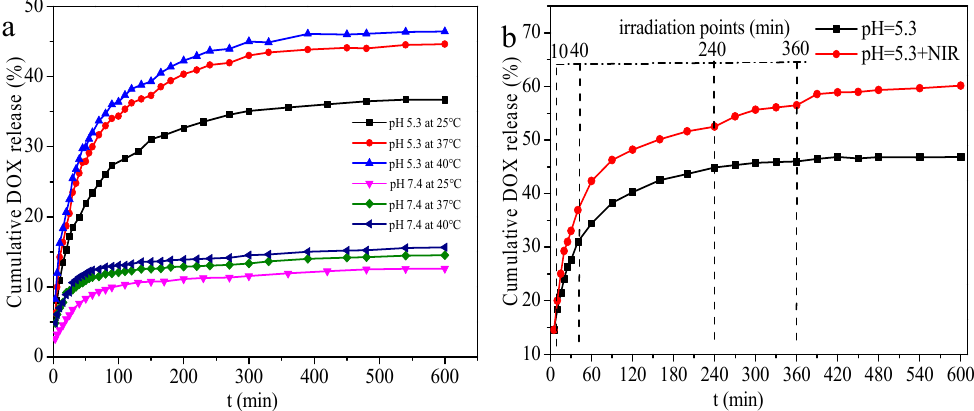
Figure 5. ( a ) Cumulative release of DOX from DOX-loaded CDHA–MGO (DOX@CDHA–MGO) at pH 7.4 and 5.3 (PBS buffer) at 25, 37, and 40 ◦ C; ( b ) DOX release profiles of DOX@CDHA–MGO in PBS at pH 5.3 with periodic laser on/off irradiation (808 nm, 2 W · cm − 2 ) at 37 ◦ C.